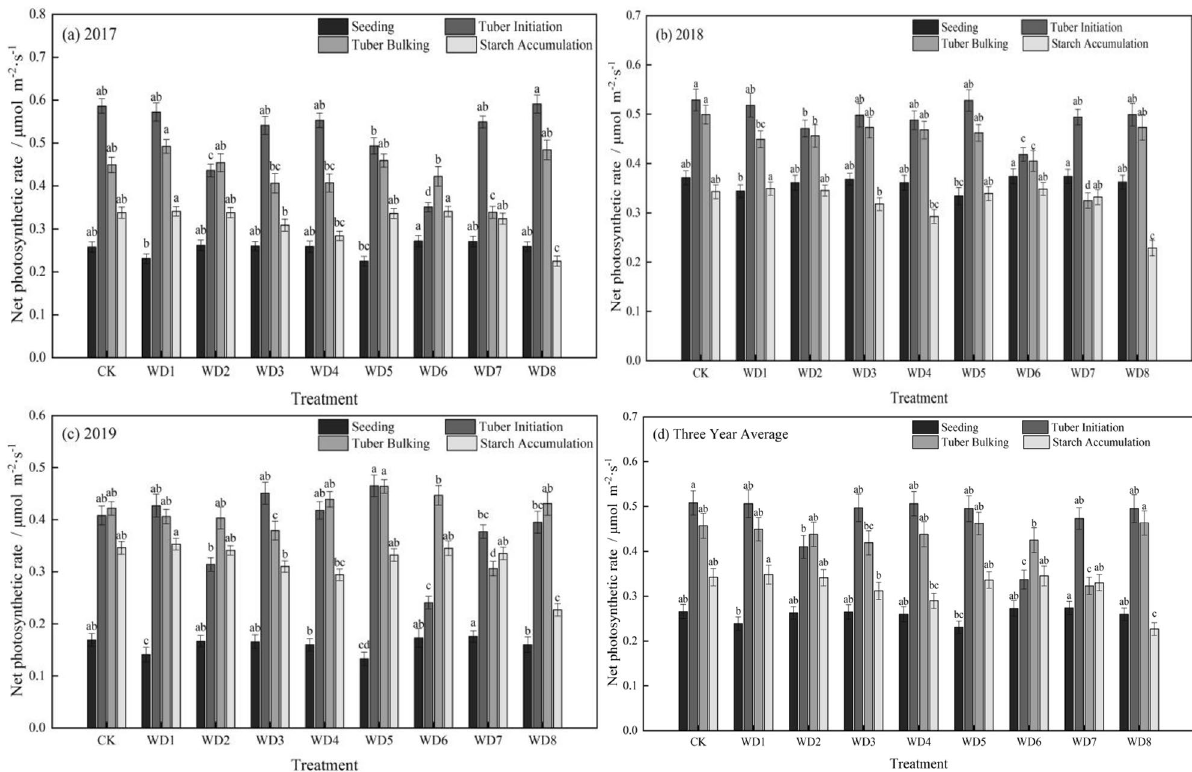
Figure 4. Rainfall and temperature in three potato seasons (2017, 2018, 2019) at the Yimin Irrigation Experimental Station, Hongshui River Administrative Office , Minle County, Gansu Province, China